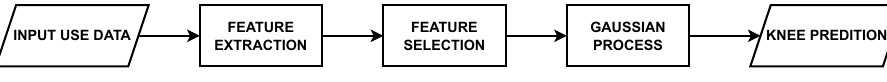
Figure 2. In the problem of predicting the knee point (point of drastic acceleration of battery condition degradation), the authors developed a strict algorithm which used a large amount of data as an input. To receive useful information from those datasets, they created extraction and selection algorithms for features. First, it has to only obtain the information necessary to build the model (like voltage, current etc.) and then specific features of it had to be selected in order to pass them to GP. This allows them to build a model, which has a possibility to achieve capacity fade trajectory estimation and predict knee point appearance from it